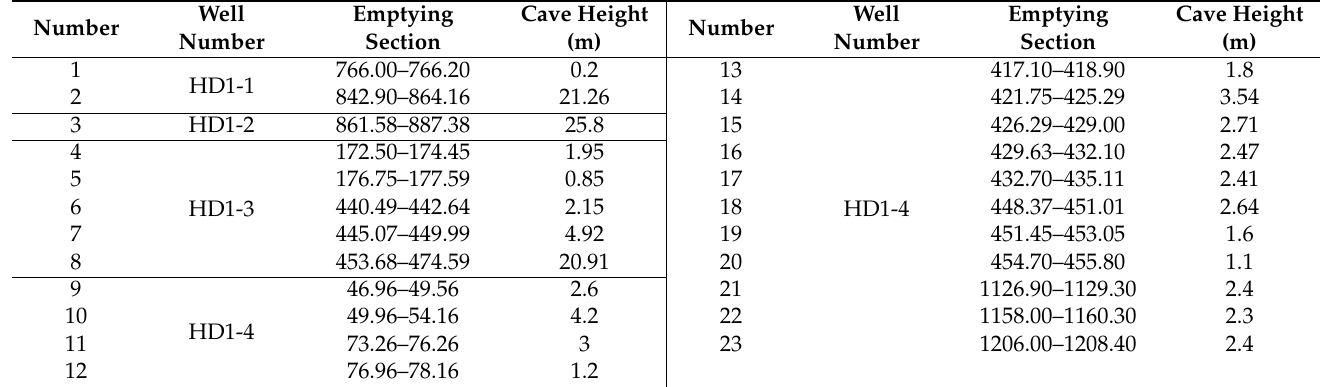
Table 1. Statistical table of emptying sections of the four drills of HD1